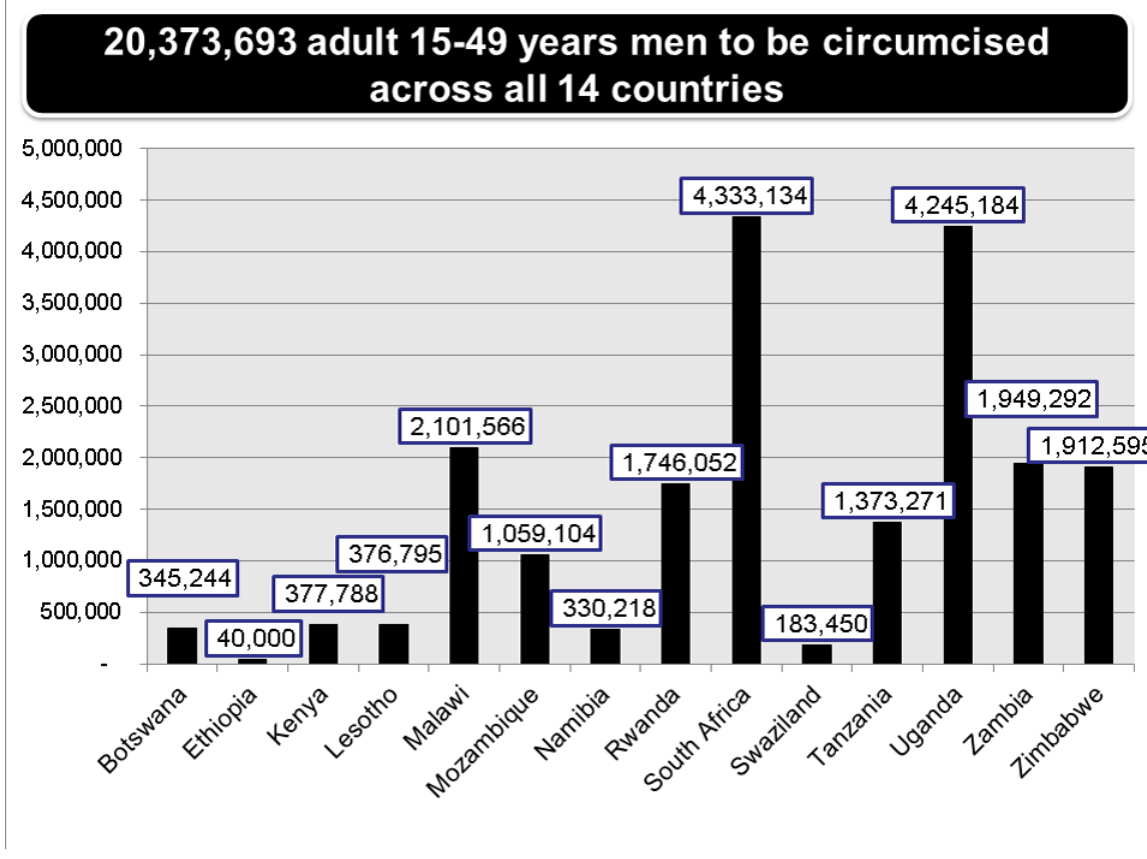
Figure 1. Number of circumcisions among men aged 15 to 49 years needed to reach 80% coverage in each of 14 priority countries/ regions within five years. For Ethiopia (Gambella Region) and Kenya (Nyanza Province), only one region or province with low circumcision rates and high HIV prevalence is included, as most men in these countries are already circumcised.